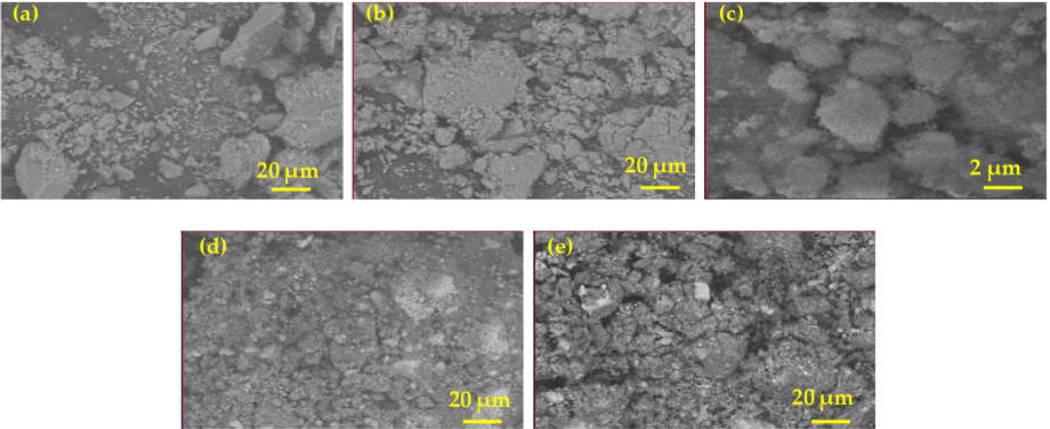
Figure 3. SEM analysis of calcined ( a ) Ni adsorbent; ( b ) Zn adsorbent ( c ) Ni and Zn adsorbent, ( d ) Zr adsorbent ( e ) Zr and Ni adsorbent.